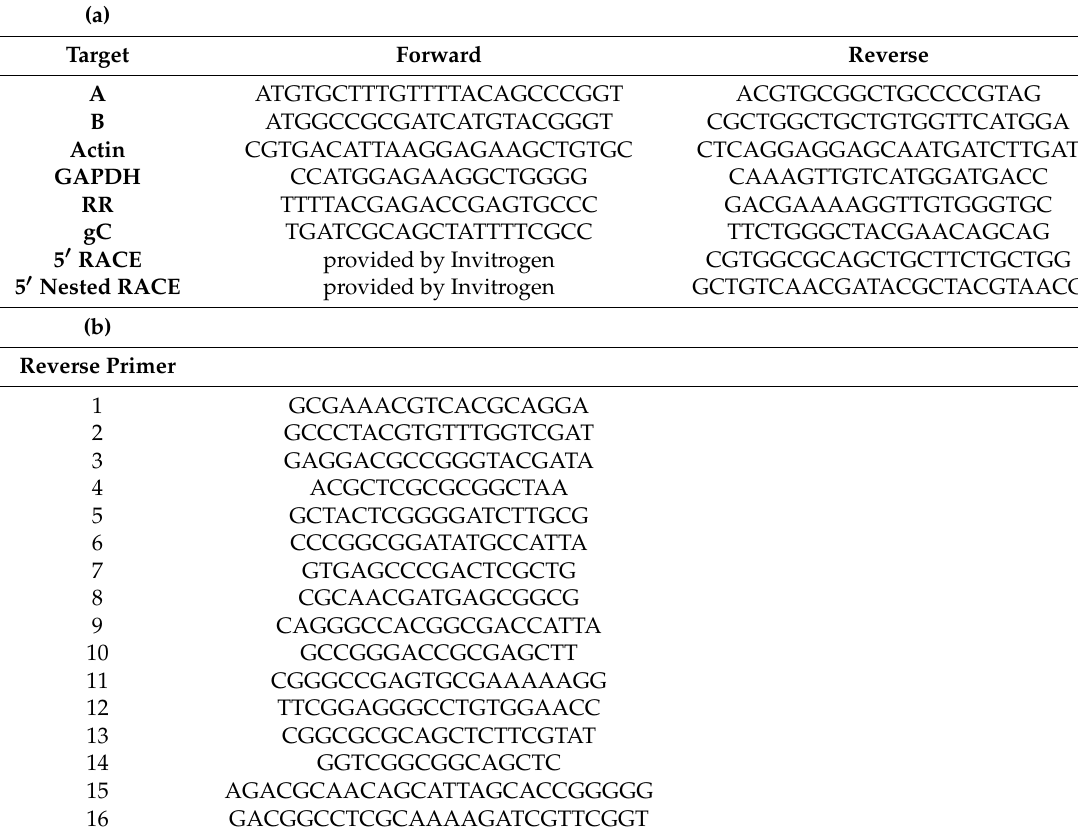
Table 1. ( a ) Table of primers used for PCR amplification. ( b ) Reverse primers used for strand-specific retrotranscription during the 3 (cid:48) walk strategy outlined in the text and in Figure